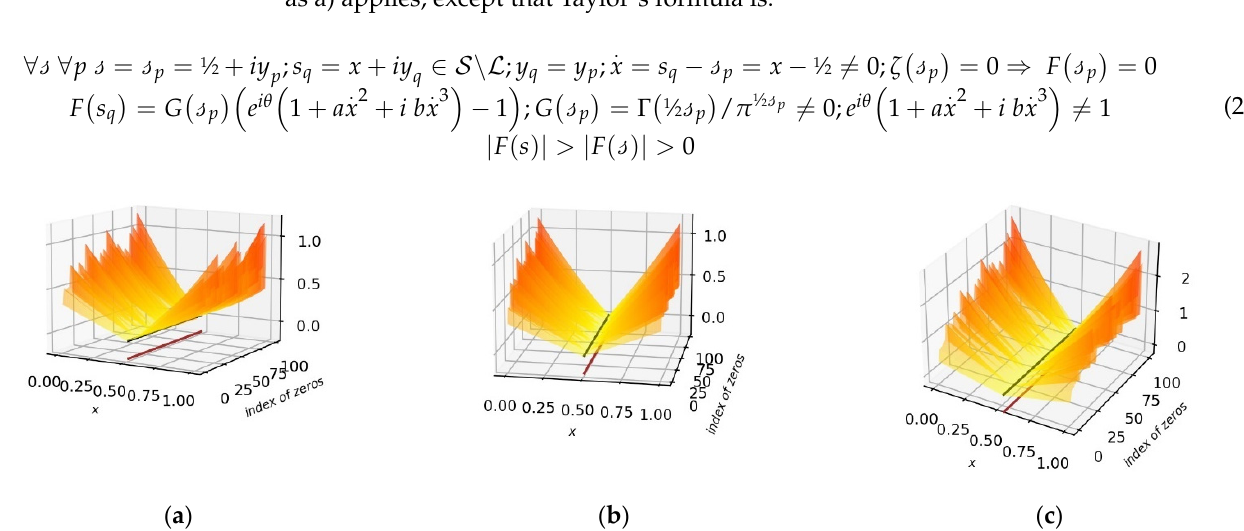
(cid:12) (cid:12) (cid:16) (cid:17) . . (cid:12) (cid:12) i θ − 1 x 2 + i b x 3 1 + a (cid:12) e (cid:12)